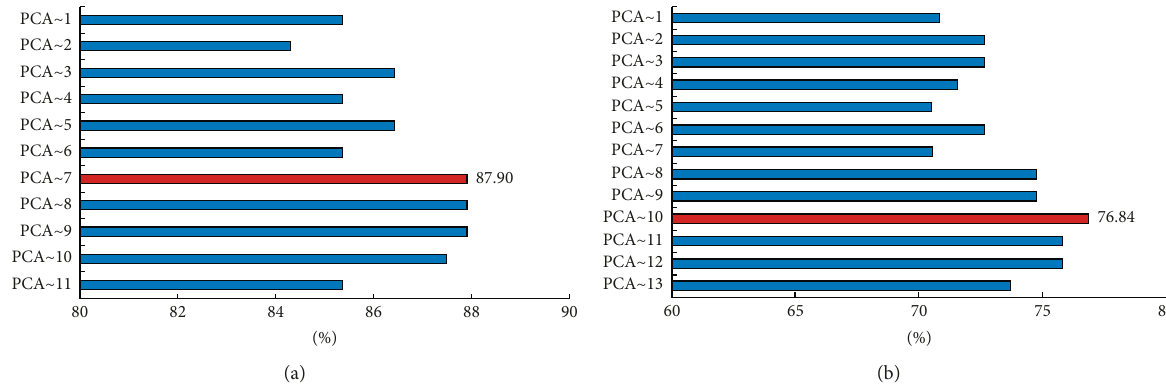
Figure 6: Classification accuracy of different PCA feature subsets: (a) behavioral features; (b) physiological features. PCA ∼ m represents PCA1 +PCA2 + . .. + PCAm.